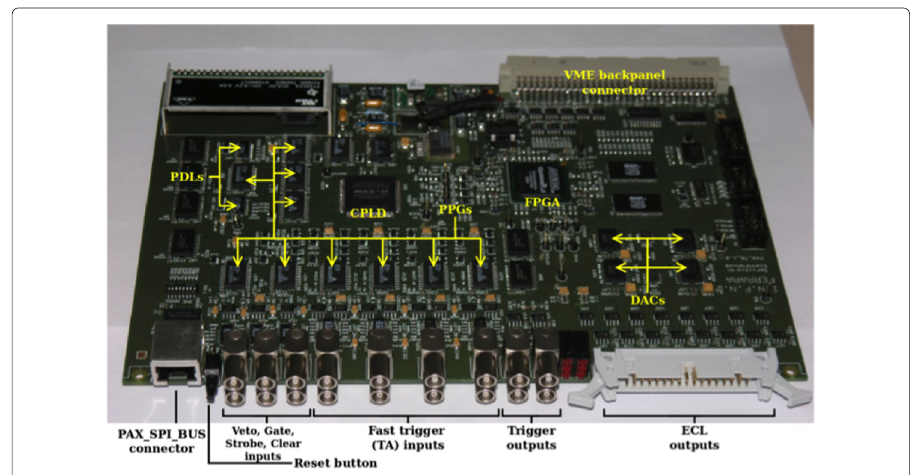
Fig. 18 Trigger module of the PAX